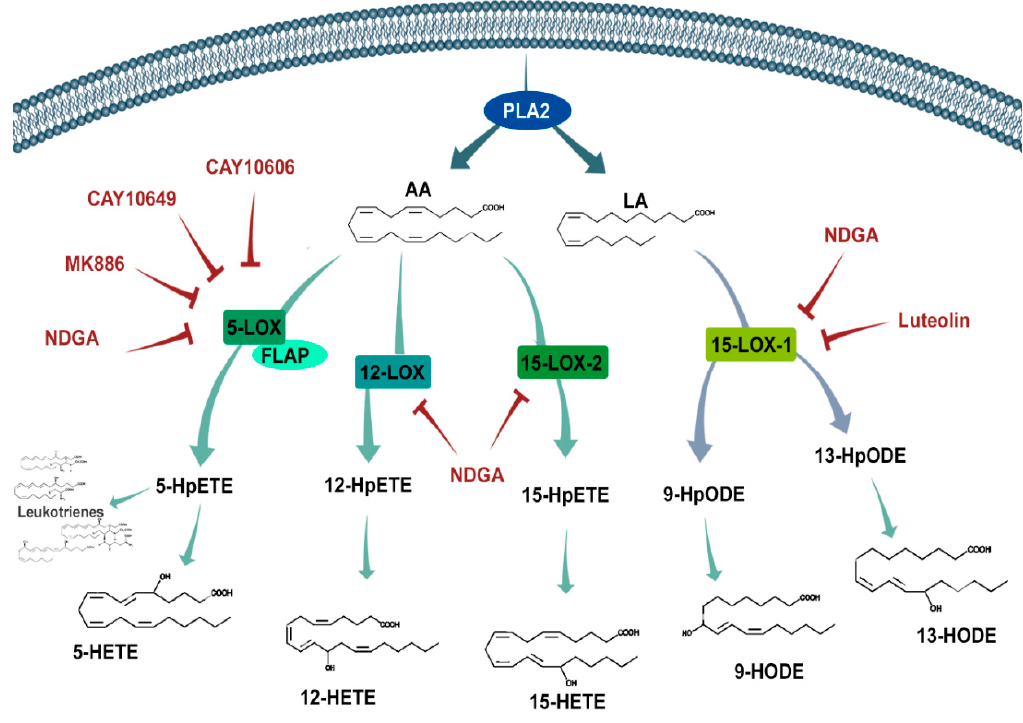
Figure 1. Schematic representation of the lipoxygenase pathway and its inhibitors. Phospholipase A2 (PLA2) releases arachidonic acid (AA) and linoleic acid (LA) into the cytosol from the cell membrane, where they are exposed to oxygenation by different lipoxygenases (5-LOX, 12-LOX, and 15-LOX) to produce intermediate hydroperoxyeicosatetraenoic acid (HpETE) and hydroperoxyoctadecadienoic acid (HpODE) products. After further oxidation, these bioactive products (hydroxyeicosatetraenoic acids (HETEs), hydroxyoctadecadienoic acids (HODES), and leukotrienes) interact with several receptors influencing different signaling cascades that are known to be involved in cell cycle, survival, FLAP—Five LOX-Activating Protein and and migration. The inhibitors (red text) used in this study aimed to prohibit these LOXs from NDGA—nordihydroguaiaretic synthesizing their products. FLAP—Five LOX-Activating Protein and NDGA—nordihydroguaiaretic acid.